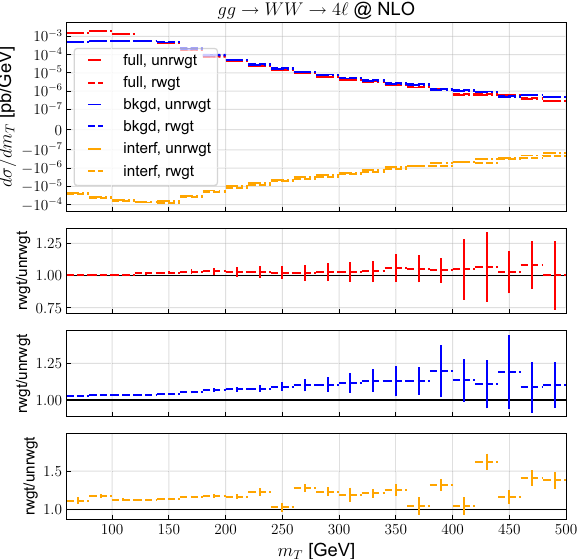
Fig. 2 Differential distribution in the transverse mass m T of the four leptonsystemin gg → e + ν e μ − ¯ ν μ atfixed-orderNLO.Weshowresults with and without reweighting of the heavy-quark mass effects in the virtual amplitude using dashed and dashed-dotted curves, respectively. The comparison is shown for the full (red), the background (blue) and the interference (orange) contributions. The lower panels show the bin- by-bin ratios of the results without reweighting to those with reweight- ing. For the nominal prediction we use a symlog scale with a linear threshold=10 − 7 5 NLO results matched to parton showers